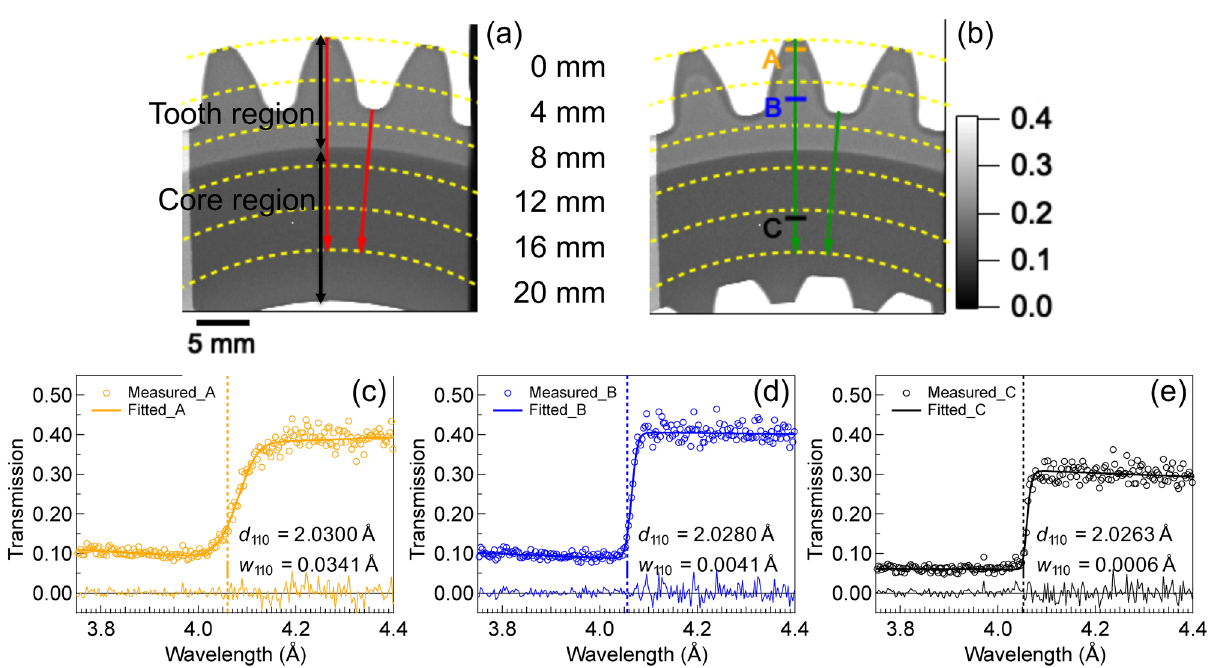
Figure 7. Neutron Bragg-edge transmission images obtained at wavelengths of 3.46–4.51 Å around the 110 edge: ( a ) for Sample 1 and ( b ) for Sample 2. Representative transmission spectra of gears obtained at point A of the hardened zone ( c ), point B of the tempered zone ( d ), and point C of the core ( e ) for Sample 2. The dashed line indicates the edge positions given by the refinement. The plot at the bottom indicates the ferent contrasts despite the same shape and thickness of the gears. These contrasts arise from differences in the microstructure and the resulting accumulated transmission value. Results shown in Fig. 7c–e represent examples of the single-edge profile fitting for the 110 lattice plane at the hardened zone, tempered zone, and core zone of Sample 2 with size of 30 × 3 pixels (1.65 × 0.165 mm 2 ): position A, position B, and position C located at ~ 1 mm, ~ 5.8 mm, and 17 mm, respectively, from the tooth tip (see Fig. 7b). Refined 110 lattice plane spacing values, d 110 , of 2.0300 Å, and 2.0263 Å, which are basically consistent with those of the martensite and ferrite phases, were determined for positions A and C, respectively. Additionally, Bragg-edge broadening was confirmed at positions